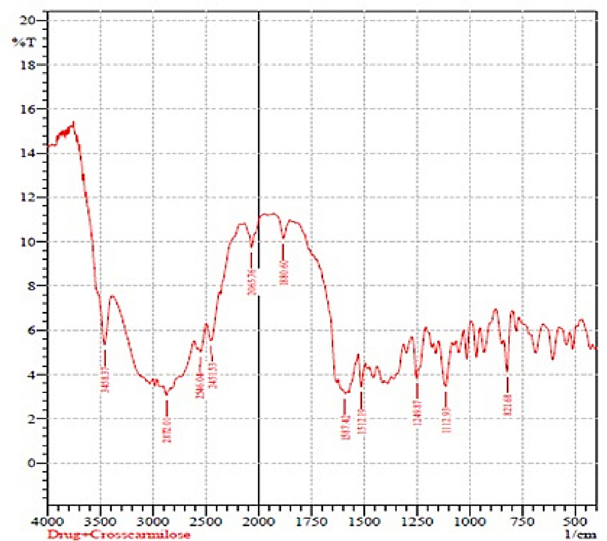
FIGURE 2 - FT-IR spectrum of metoprolol tartrate with sodium